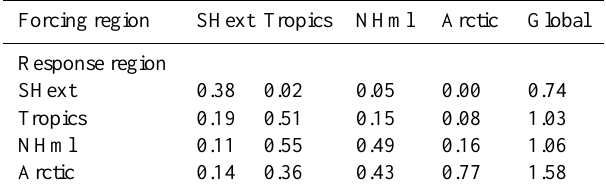
Table 1. RTP coefficients (unitless regional response per W m − 2 forcing in the indicated area relative to global